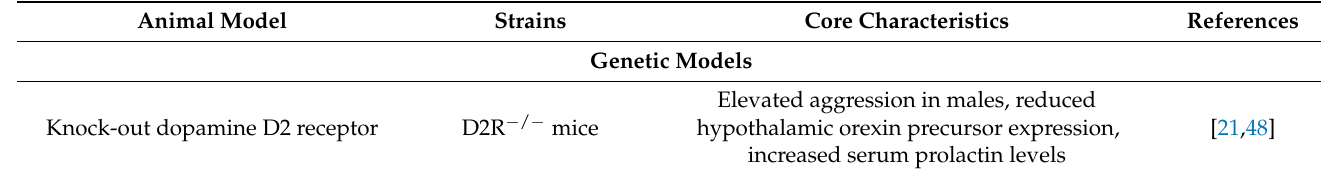
Table 1. Animal models of aggression associated with depressive syndrome. This summary provides a neurobiological classification of animal models of aggression associated with depressive syndrome starting with an impact of a single gene out to varieties of environmental factors. Core character- istics highlight the important role of monoamines, pro-inflammatory shifts and oxidative stress in the development of a valid animal model that recapitulates behavioural phenotypes of increased aggressiveness associated with pro-depressant changes. Abbreviations are: BDNF—brain-derived neurotrophic factor; GSK3- β —glycogen synthase kinase-3 beta; GABA—gamma-aminobutyric